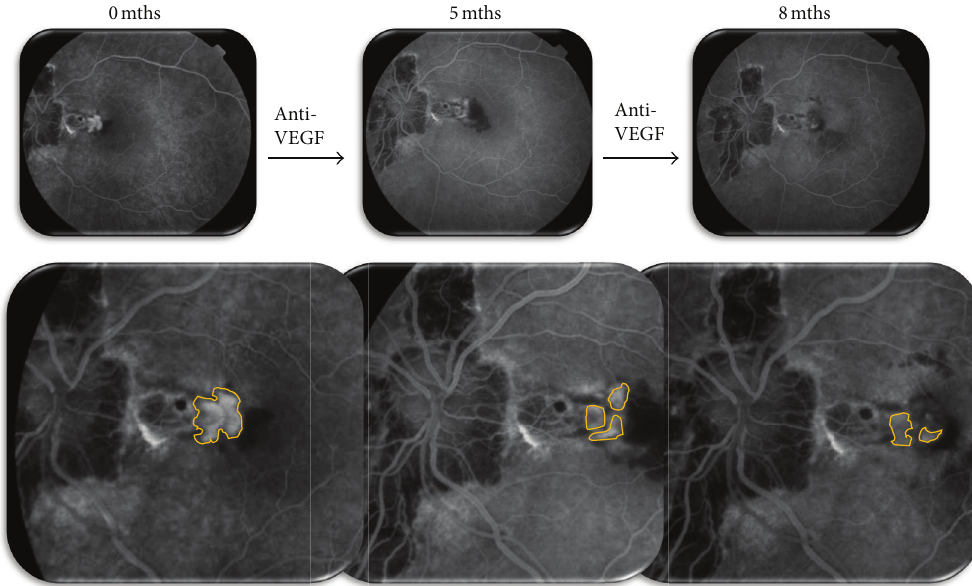
Figure 1: Choroidal neovascularization (CNV) dynamics after repeated anti-VEGF therapy (CNV size is circumscribed with yellow color; images shown are at the 40th second of fluorescein